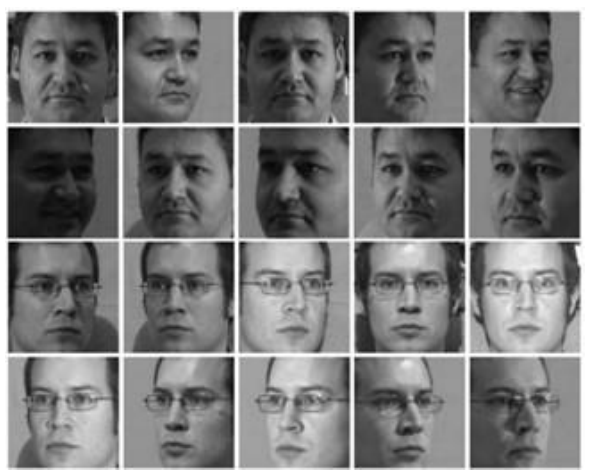
Figure 6. Modified Multi-PIE image samples used in the experiment.